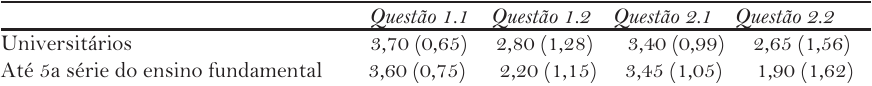
Médias de Acertos Obtidos pelos Adultos em Função do Nível de Escolaridade (3 o